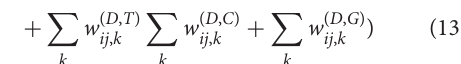
memory subnetworks. In addition, neurons which prefer “G5” L 1 due to the synaptic transmission delays (Liang et al.,